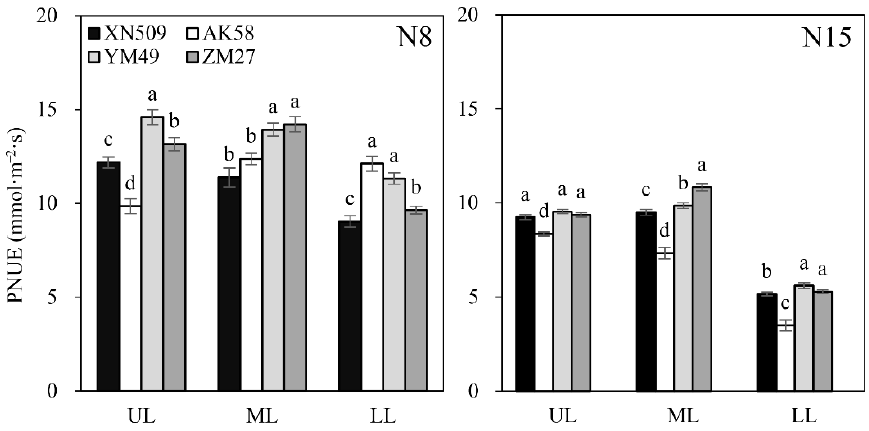
Figure 7. The vertical distribution of PNUE of two N-efficient and two N-inefficient winter wheat varieties under different N levels. UL: upper layer. ML: middle layer. LL: lower layer. Different letters within each column indicate significant differences according to Duncan’s multiple-range test ( p = 0.05).